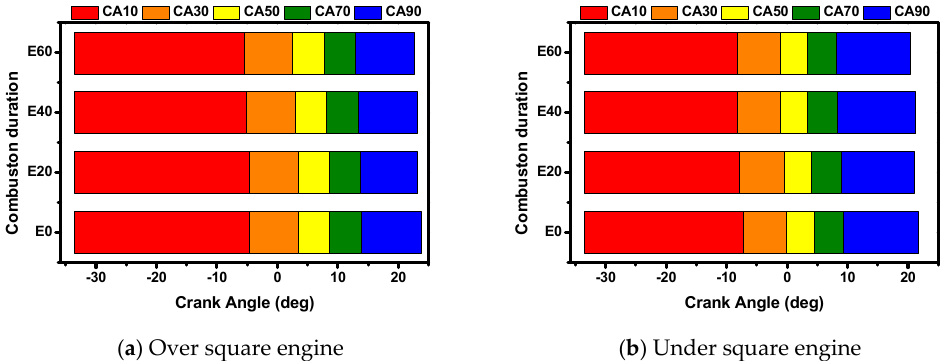
Figure 8. Combustion duration for over- and under-square engine as ethanol blending ratio. Table 5. Crank angle of combustion duration for over- and under-square engine as ethanol blending ratio. Over Square CA10